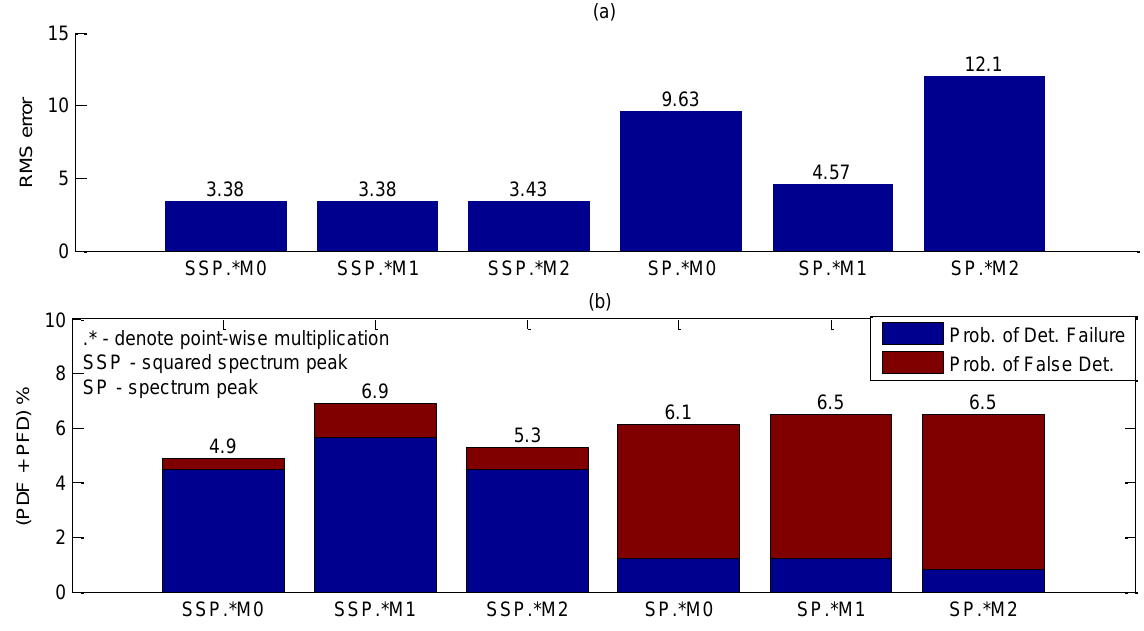
Figure 17. Comparison of spatiotemporal mapping for 0.3 s of acquisition. ( a ) Squared spectrum peak mapping. ( b ) Zero moment (M multiplication of squared spectrum peak and M